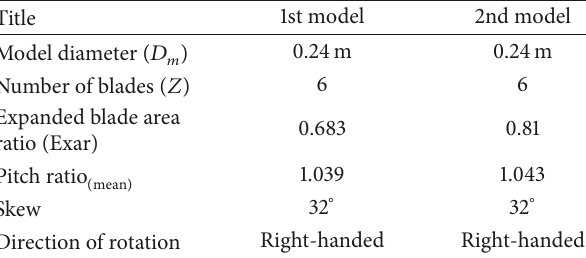
Table 1: Main parameters of the